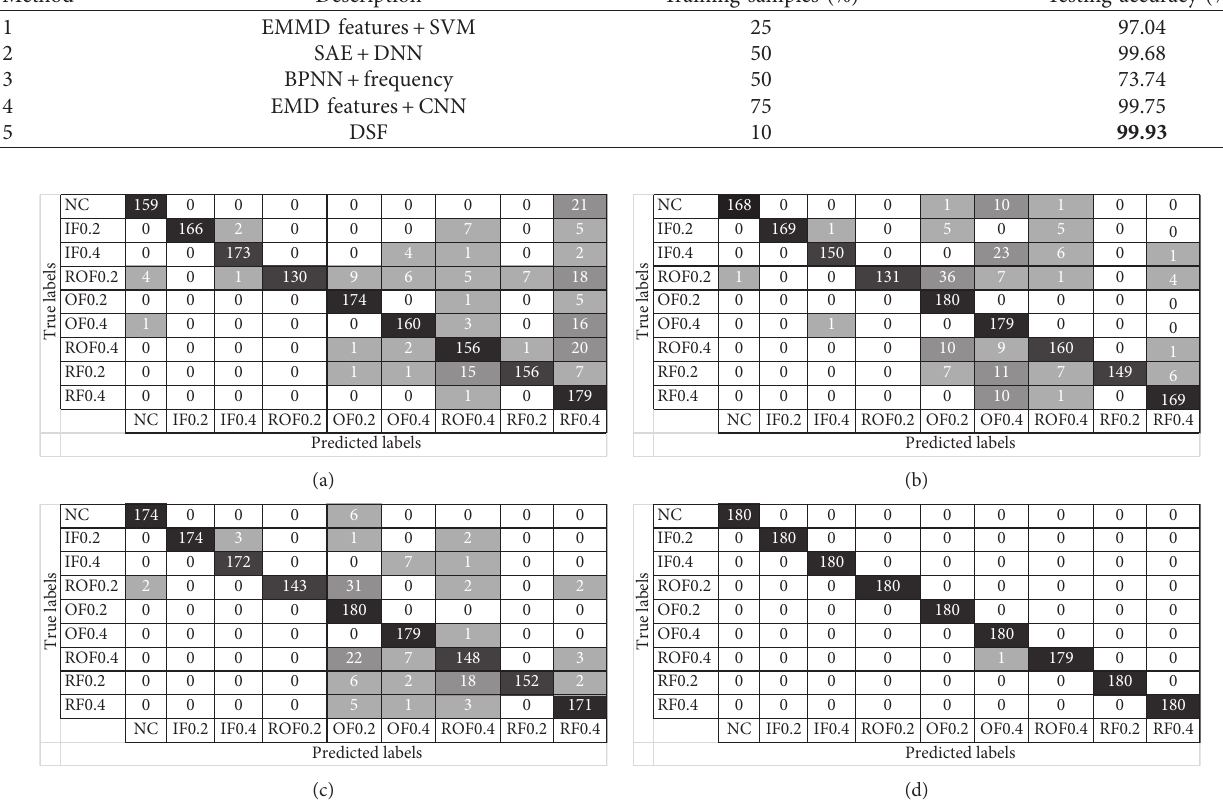
Figure 9: Confusion matrixes for bearing dataset: (a) SF, (b) L1-SF, (c) L2-SF, and (d) DSF.